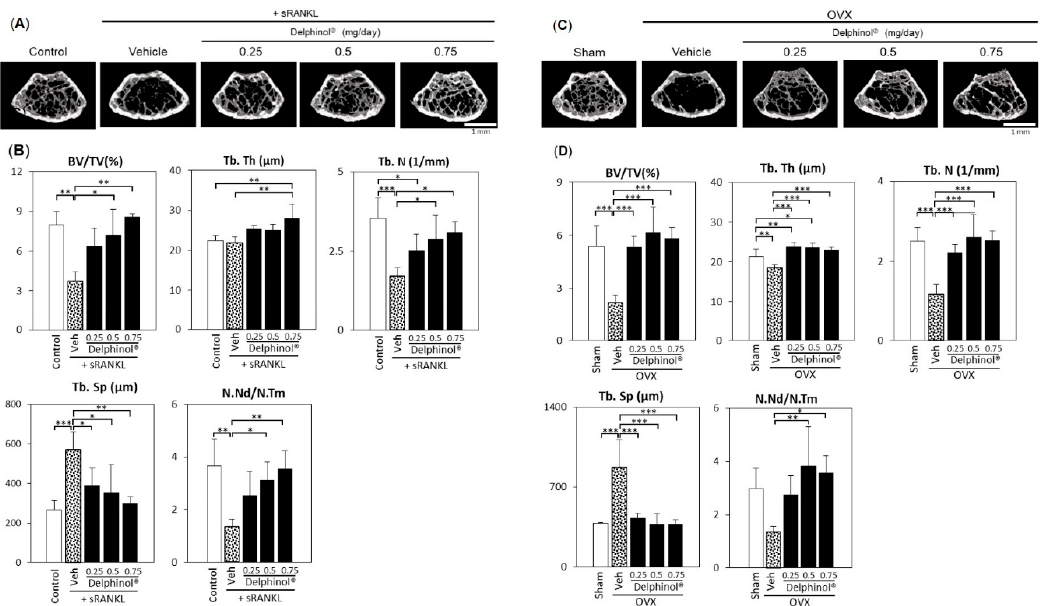
Figure 6. Protective effect of Delphinol ® on bone loss in sRANKL and OVX-induced osteopenia mice. ( A ) Representative microcomputed tomography (micro-CT) images of the distal femurs of intact mouse (control), sRANKL-induced osteopenia mouse (vehicle), and MBE-treated sRANKL-induced osteopenia mice (MBE; 0.25, 0.5, 0.75 mg/mouse/day). ( B ) Microarchitectural indices of second trabecular spongiosa of the distal femurs as measured by micro-CT. ( C ) Representative micro-CT images of the distal femurs of sham-operated mouse (Sham), OVX-induced osteopenia mice (vehicle), and MBE-treated OVX-induced osteopenia mice (MBE; 0.25, 0.5, 0.75 mg/mouse/day). ( D ) Microarchitectural indices of second trabecular spongiosa of the distal femurs as measured by micro-CT. Values are expressed as mean ± SD ( n = 5–8). * p < 0.05, ** p < 0.01, *** p < 0.001.